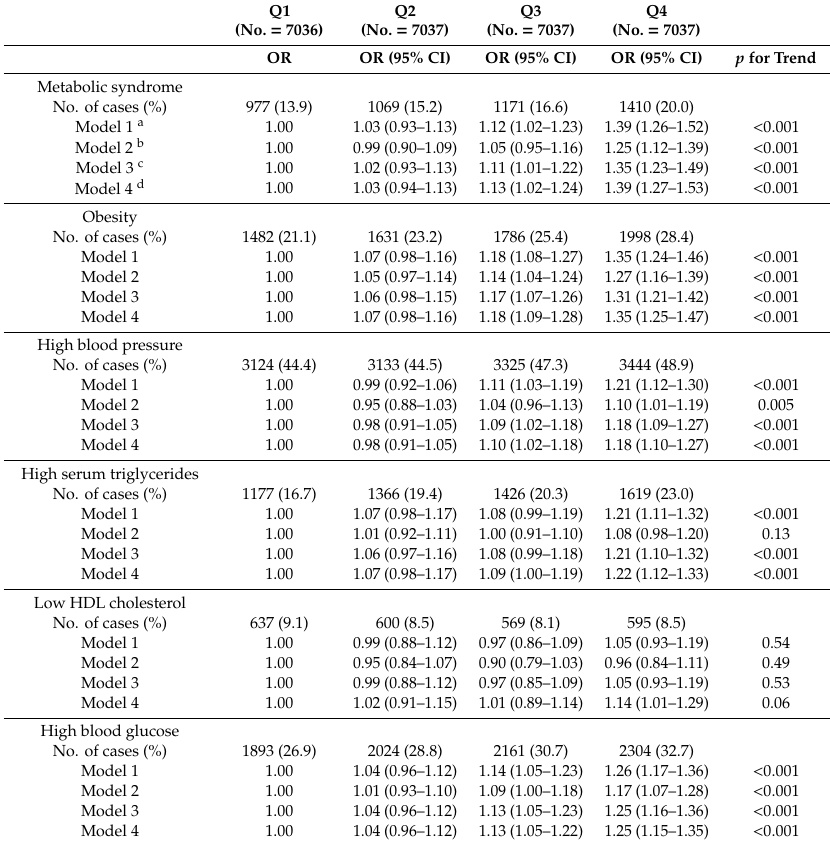
Q, quartile; OR, odds ratio; CI, confidence interval; HDL, high-density lipoprotein. a Adjusted for sex, age, study site, smoking and drinking habits, physical activity level, total energy intake, and school career. b Model 1 plus nutrient pattern 1 (fiber, iron, potassium and vitamins pattern) scores. c Model 1 plus nutrient pattern 2 (fat and fat-soluble vitamins pattern) scores. d Model 1 plus carbohydrate